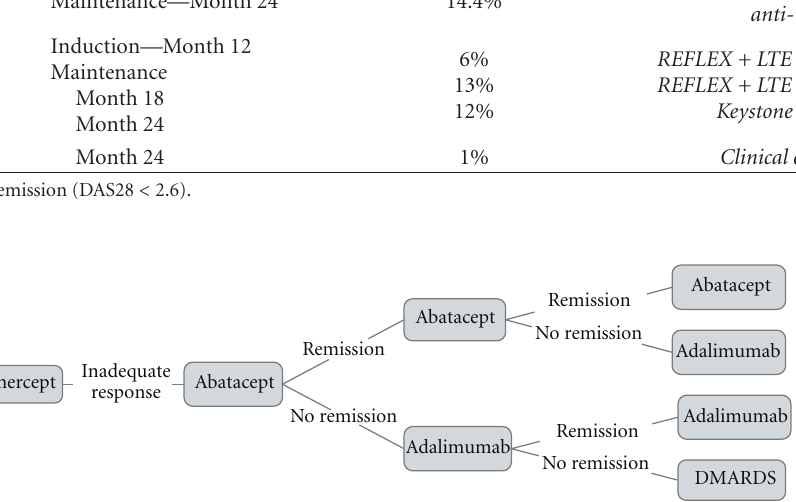
Figure 1: Model structure of Sequence A using “remission” as clinical